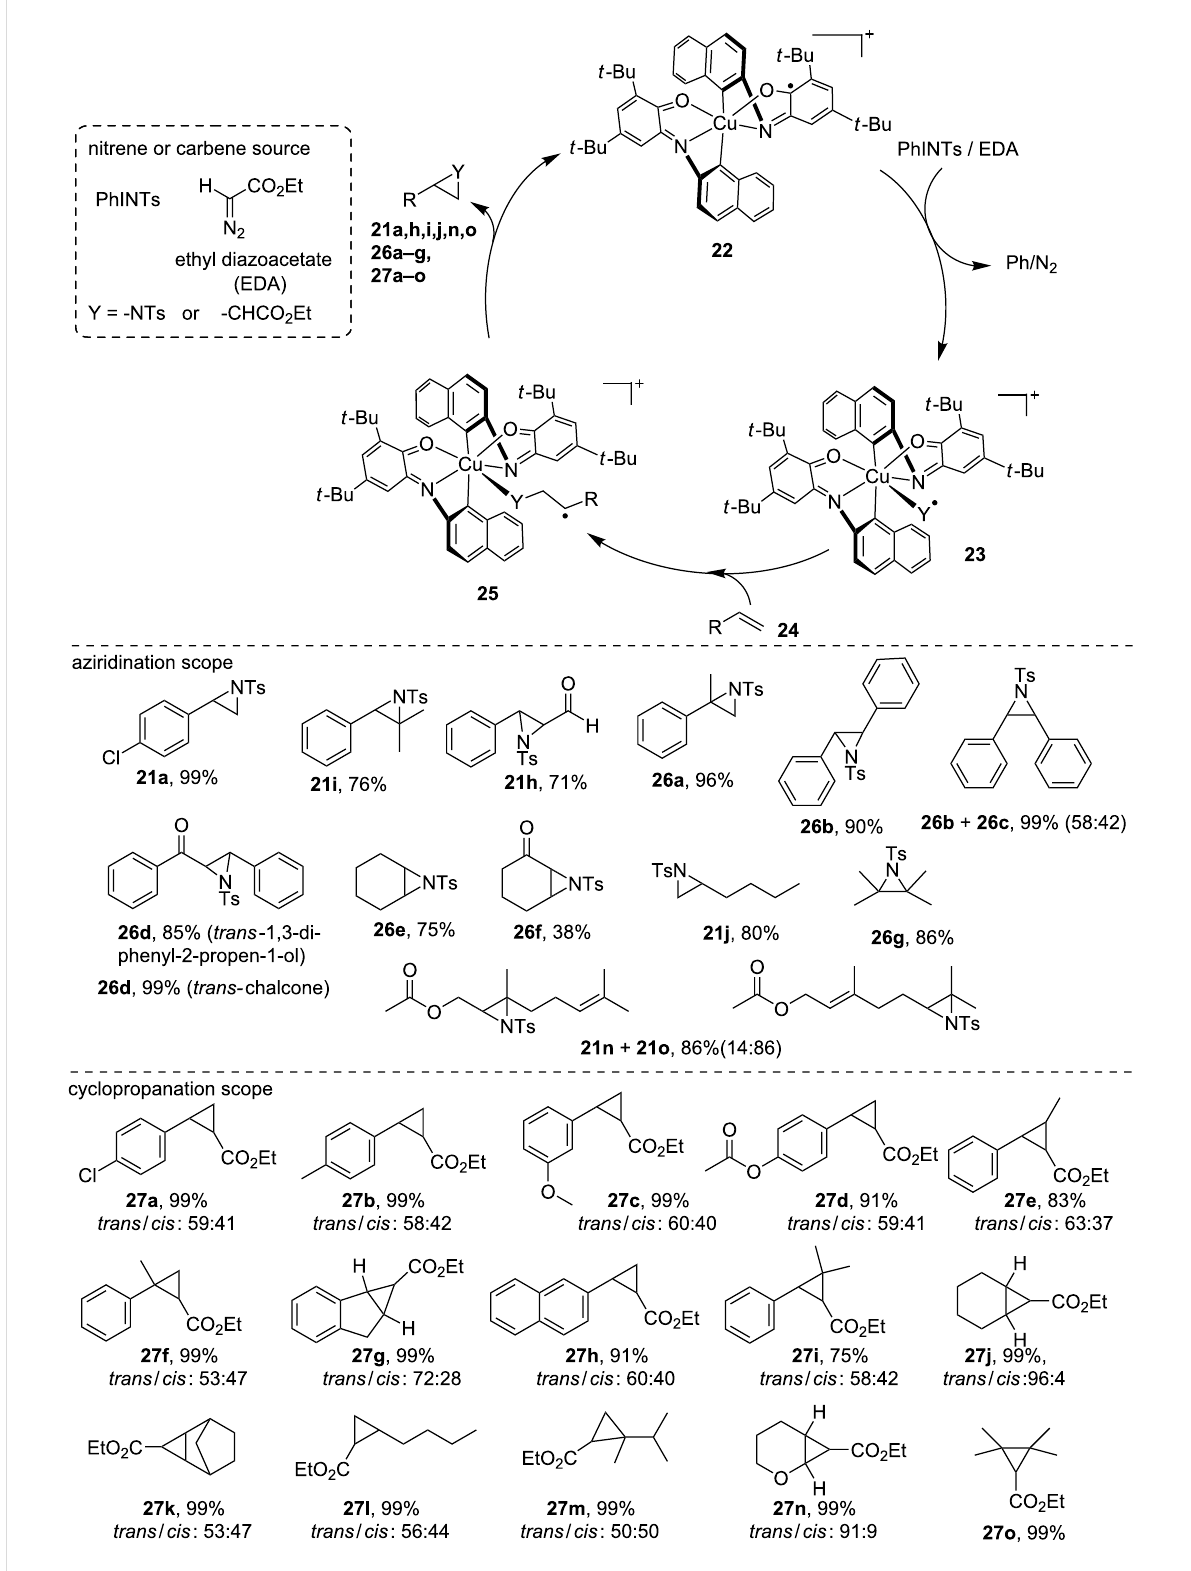
Scheme 12: Nitrogen-group and carbon-group transfer in copper-catalyzed aziridination and cyclopropanation through a strained redox-active ligand framework reminiscent of the entatic state model. Products are obtained as a mixture of cis and trans